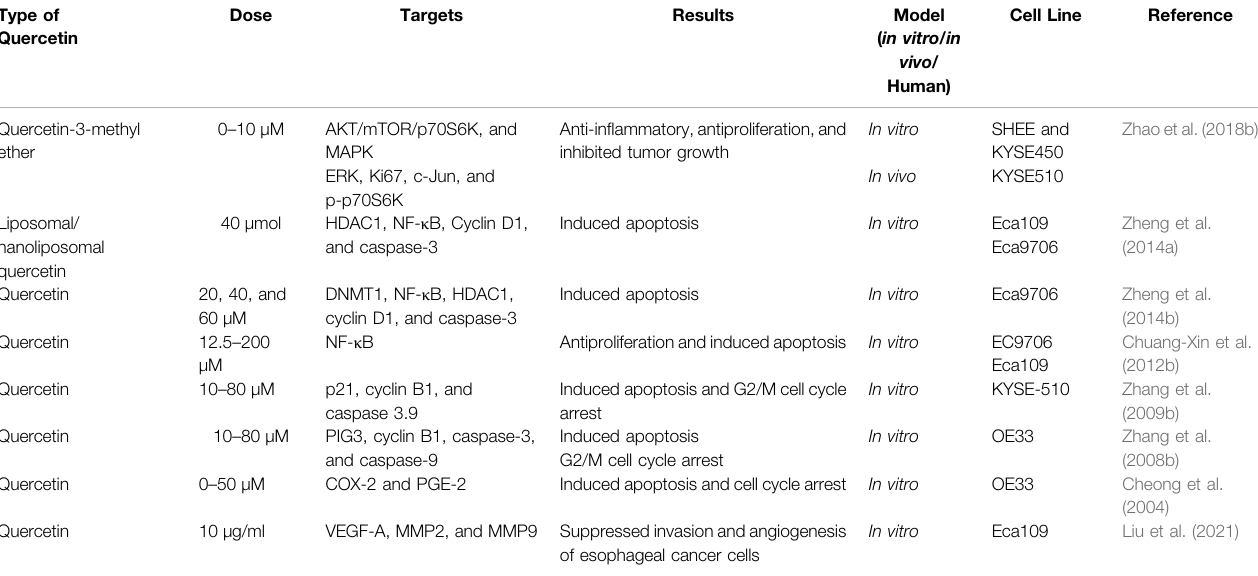
TABLE 4 | Studies on the therapeutic effects of quercetin in esophageal